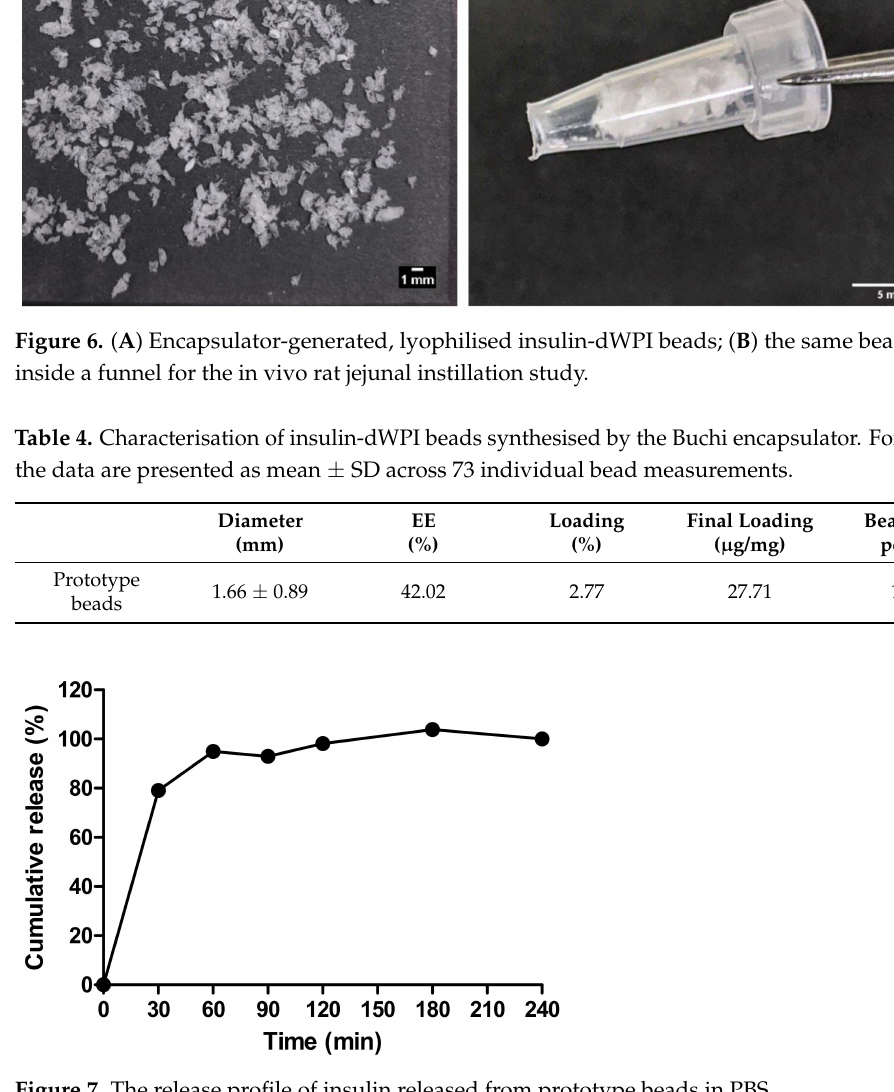
Figure 7. The release profile of insulin released from prototype beads in